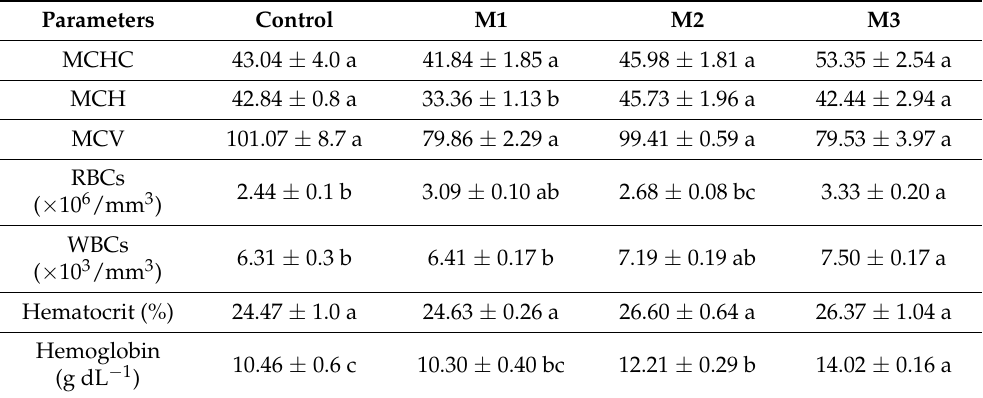
Table 3. Hematological indices of C. carpio fed basal diet incorporated with zero (control), 0.5% (M1), 1% (M2), and 2% (M3) of Myristica fragrans for four weeks.